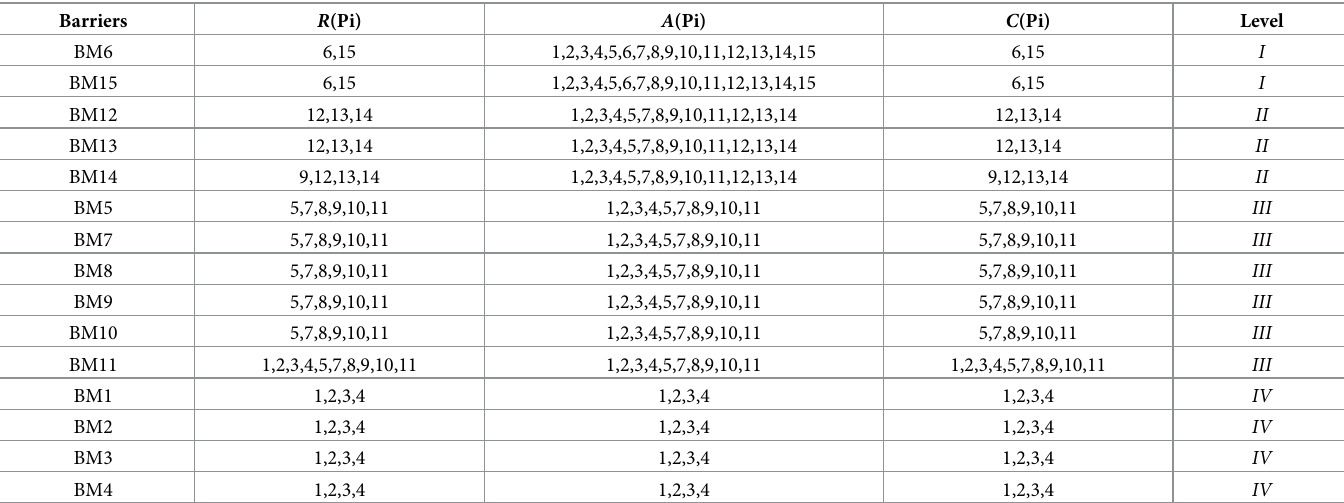
Table 9. Hierarchical division of barriers.